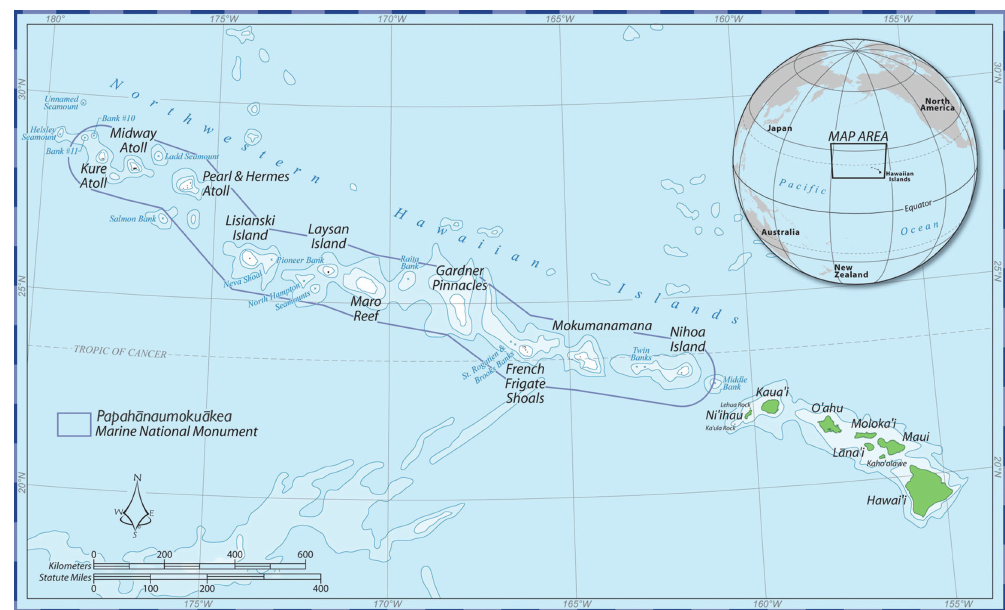
Figure 1: Map showing the Hawaiian Archipelago, comprised of the inhabited high islands of the main Hawaiian Islands and the uninhabited reefs, banks, and atolls of the Northwestern Hawaiian Islands. The boundary for the Papah¯anaumoku¯akea Marine National Monument is indicated in black. Map courtesy of the NOAA Papah¯anaumoku¯akea Marine National Monument O ffi